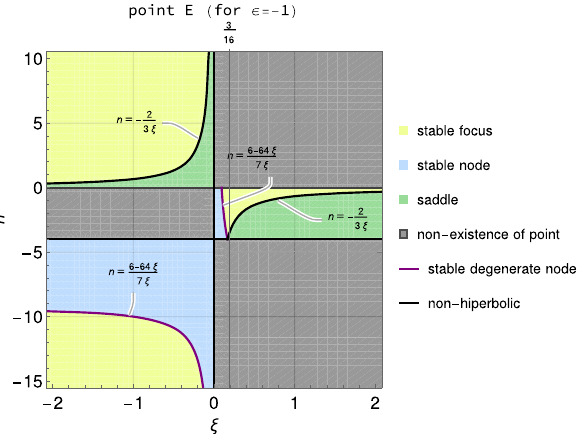
Fig. 5 Bifurcationdiagram of thelocalstabilityof point E for ε = − 1